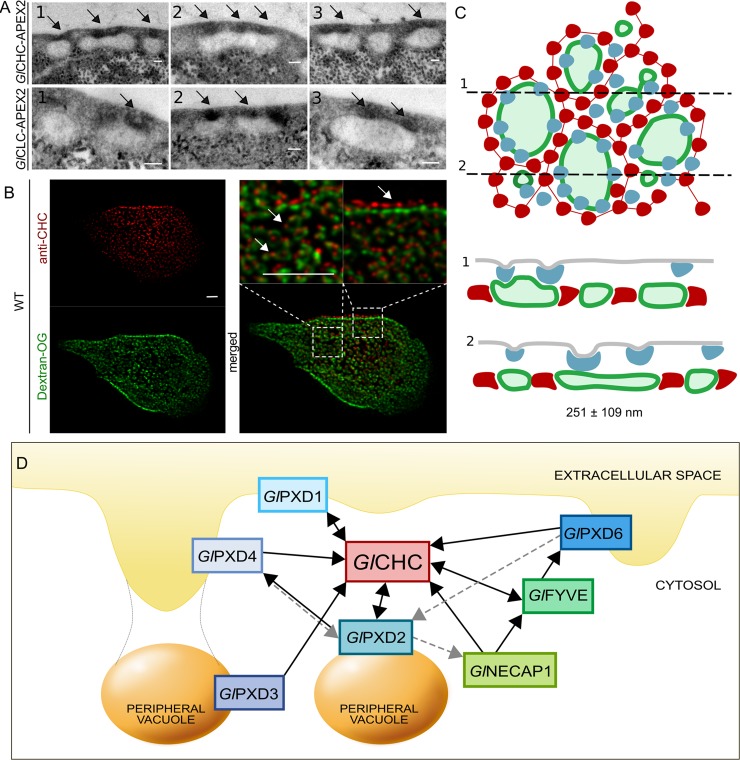
A working model for PV-associated nanoenvironments defined by clathrin assemblies and PIP-binding proteins.(A) Electron microscopy images of G. lamblia cells expressing an APEX2-tagged GlCHC (upper panels) or GlCLC (lower panels) reporter show darker APEX2-derived deposits at the PM-PV interface (arrows). Scale bar: 0.1 μm. (B) IFA analysis of a representative non-transgenic wild-type cell labelled with Dextran-OG and anti-GlCHC antibodies to illuminate PV lumina and the PV-PM interface, respectively. Scale bar: 1 μm. (C) Schematic reconstruction of a surface view (left panel) of the PV system associated to clathrin assemblies (blue) and GlPXD3 coats (red), based on data presented in this report and in [13]. PV membranes and lumina are represented in dark and light green, respectively. Cross-sections at (1) and (2) yield views in the right panel, highlighting foci of clathrin assemblies beneath the PM, above GlPXD3’s coat-like deposition pattern surrounding PVs. (D) An overview of the G. lamblia PIP-binding interactome associated to PVs. All represented PIP-binding proteins were found to contact clathrin assemblies (GlCHC) in either reciprocal (double-headed arrows) or one-way (single-headed arrows) modes of interaction, following filtering of co-IP data either at high (black solid lines) or low (grey dashed lines) stringency.